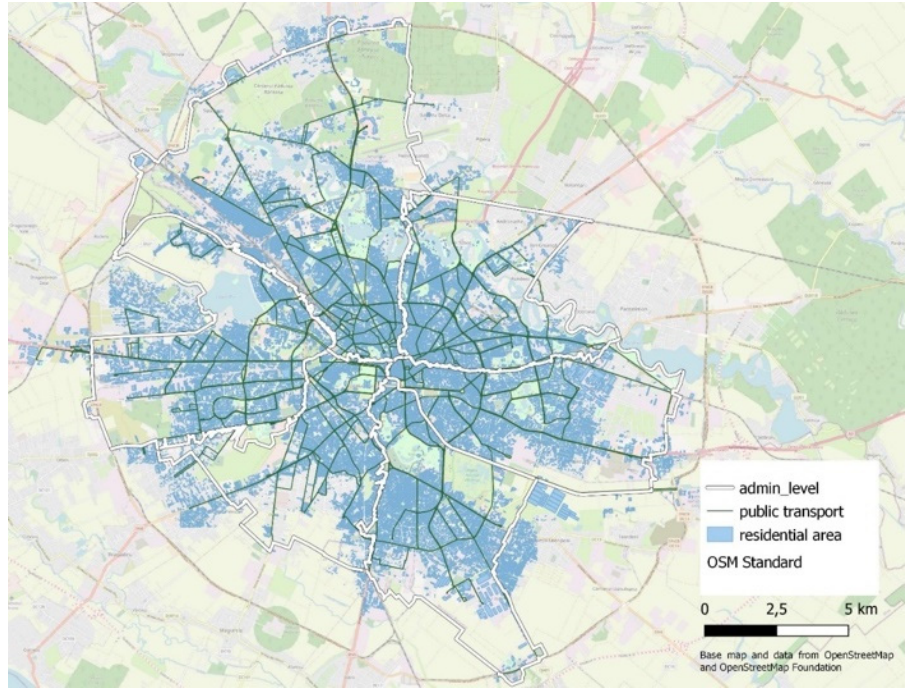
Figure 6. Residential areas and public transport network (© OpenStreetMap contributors).